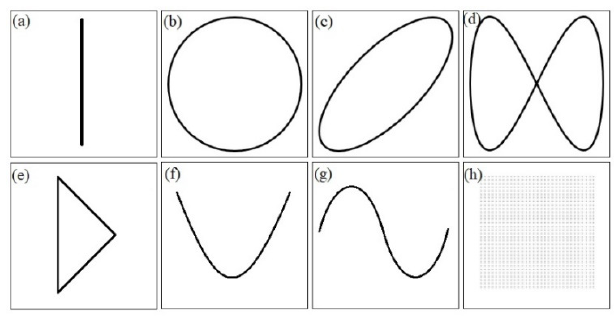
Figure 2. Electron-beam scanning figures. ( a ) Line; ( b ) circle; ( c ) ellipse; ( d ) infinity; ( e ) triangle; ( f ) parable; ( g ) sine; ( h ) matrix.